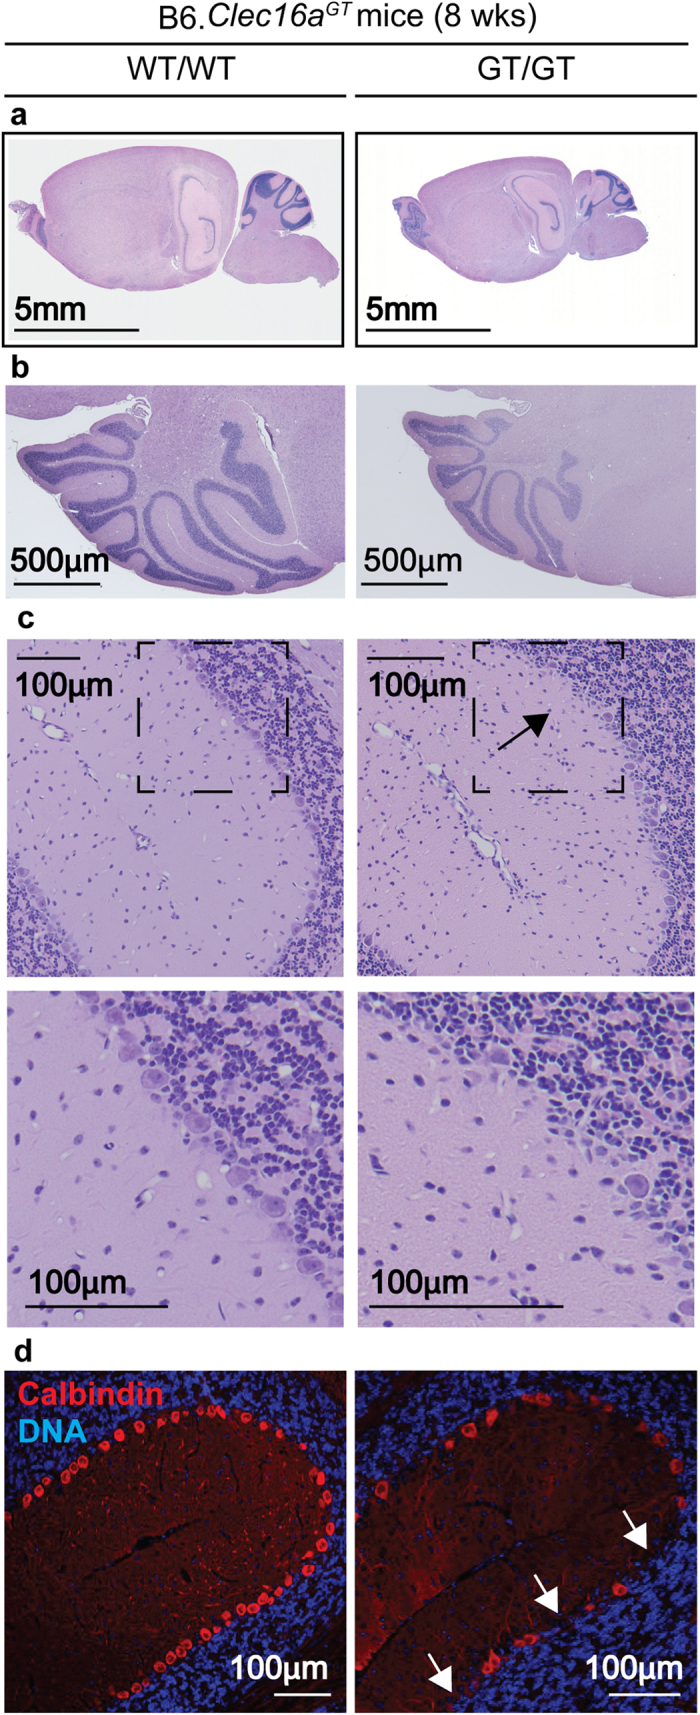
Mutation of Clec16a results in neurodegeneration characterized by loss of Purkinje cells.(a–d) H & E (a–c) or calbindin immunofluorescence images (d) of brains of 8 week old B6.Clec16aGT mice (representative of n = 3 mice/group). Arrows indicate loss of Purkinje cells.